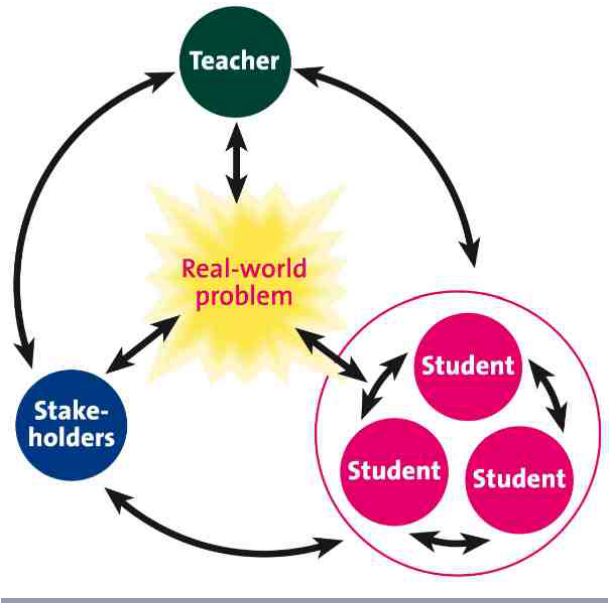
Fig. 4. New forms of teaching are needed to educate a new generation of sustainability experts and foster inter- and transdisciplinary research and partnerships. In a transdisciplinary case study at ETH Zurich (Stauffacher et al. 2006), students work in groups and address real-world problems together with teachers and actors from practice (ETH-UNS